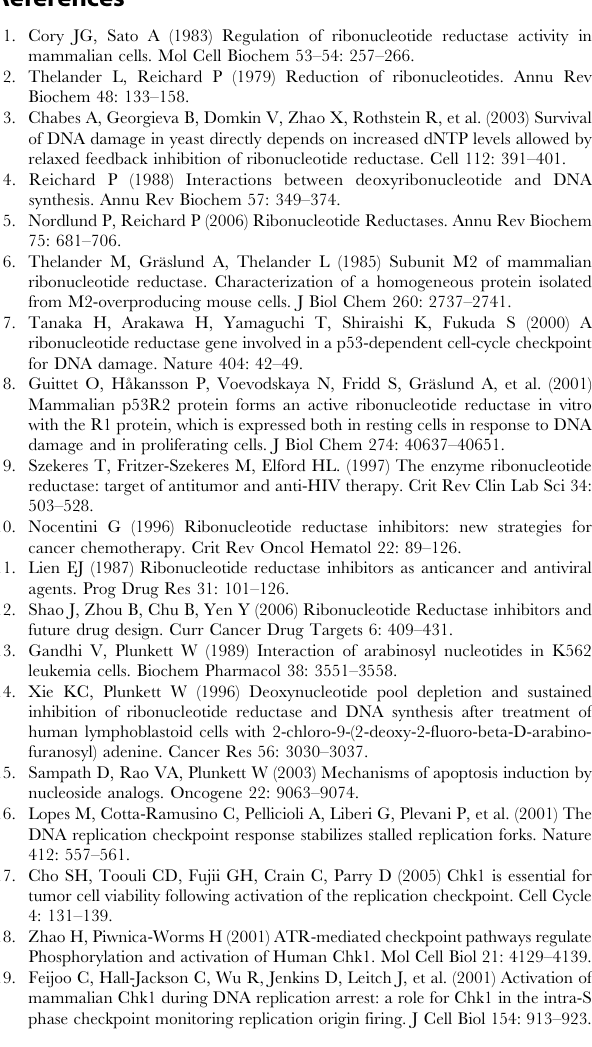
Figure S1 RRM1 and RRM2 depletion using multiple siRNAs lead to phosphorylation of Chk1 and c -H2AX in U2OS cells. Figure S2 Inhibition of Chk1 with siRNA or clinical compound, SCH900776 (MK8776) with RRM1 or RRM2 shows similar accumulation of DNA damage in U2OS cells.